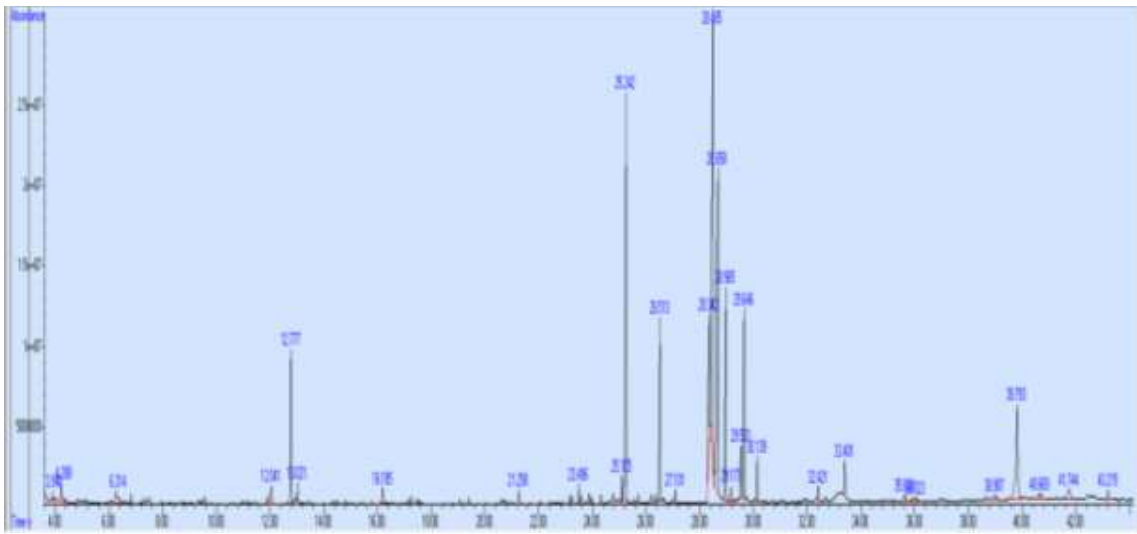
Figure 3. GC-MS analysis of petroleum ether leaves extract of Leucaena leucocephala by hot extraction